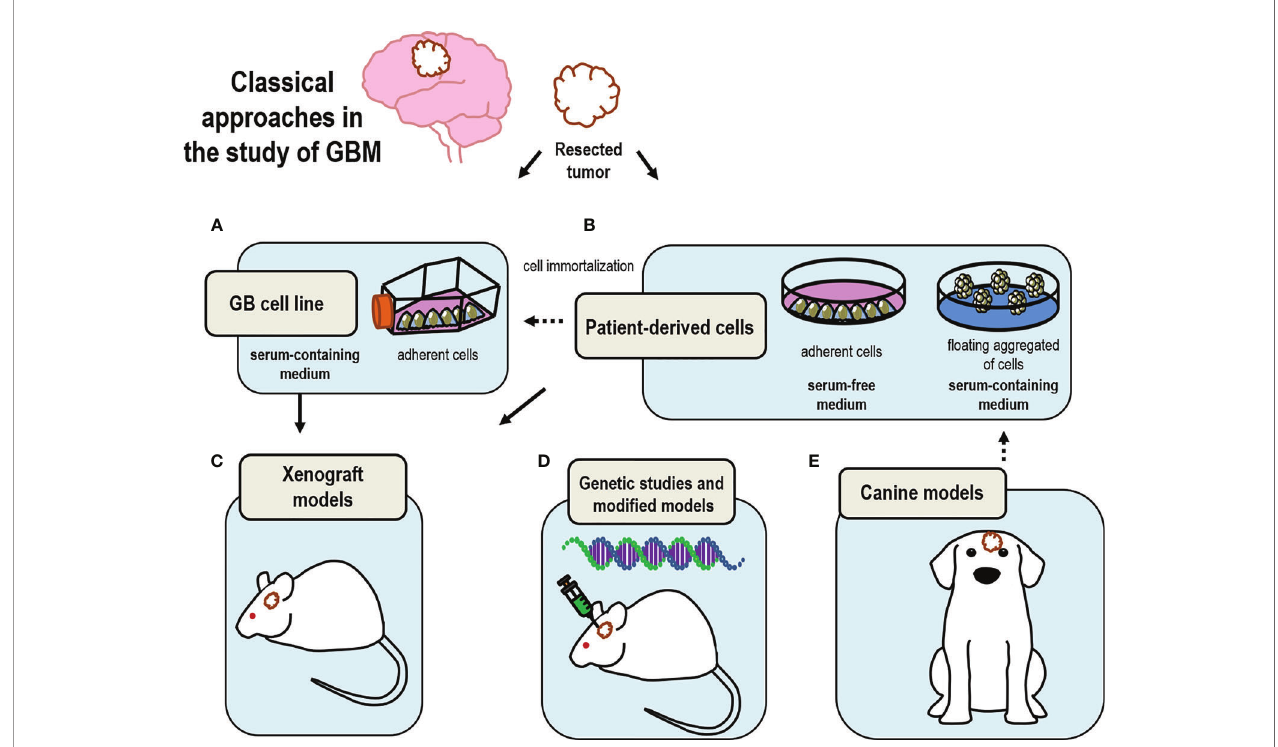
FIGURE 1 | Drawing summary of classical models currently in use to study GBM. Tumor samples resected from patients upon surgery are used to (A) generate immortalized cell lines that can be maintained in time; (B) select GSC by culturing these cells as neurospheres under fl oating conditions; (C) produce xenograft models by transplanting either cultured isolated cells or tumor tissue; (D) perform genomic analysis to select candidate genes to produce genetically modi fi ed mice models of GBM; (E) canine models are good model for the study of GBM based on their analogies with human